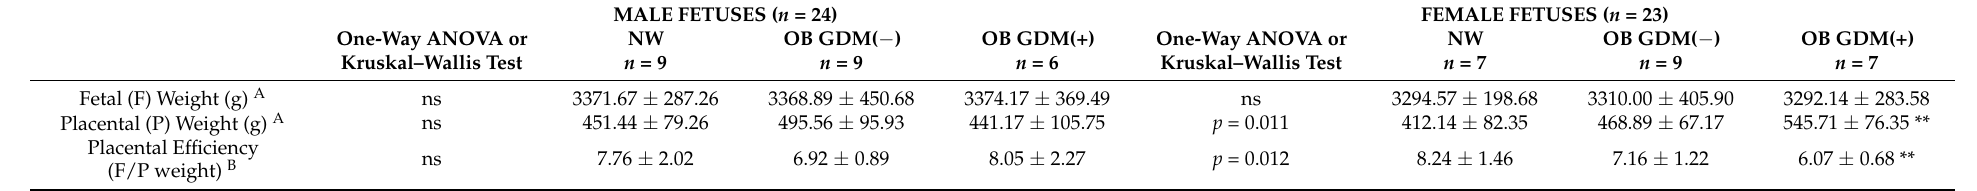
Table 3. Fetal and placental characteristics separately described across